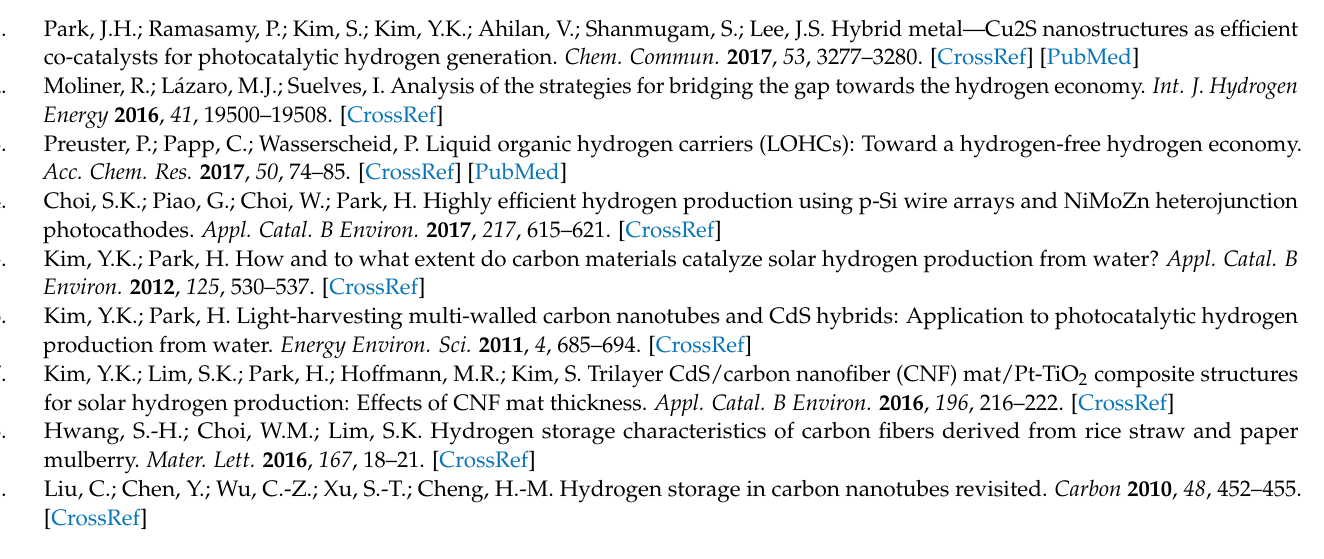
Figure S3. N 2 adsorption (empty) and desorption (filled) isotherms of (a) Pd-deposited APCF_H 0.3. (b) Hydrogen up-takes of Pd-deposited APCF_H with different concentrations of PdCl 2 solutions (0 mM (black circles), 0.1 mM (red rectangles), 0.5 mM (blue rhomboids), and 1 mM (green hexagons). Inset figure: enlarged graphs of hydrogen uptake behavior of